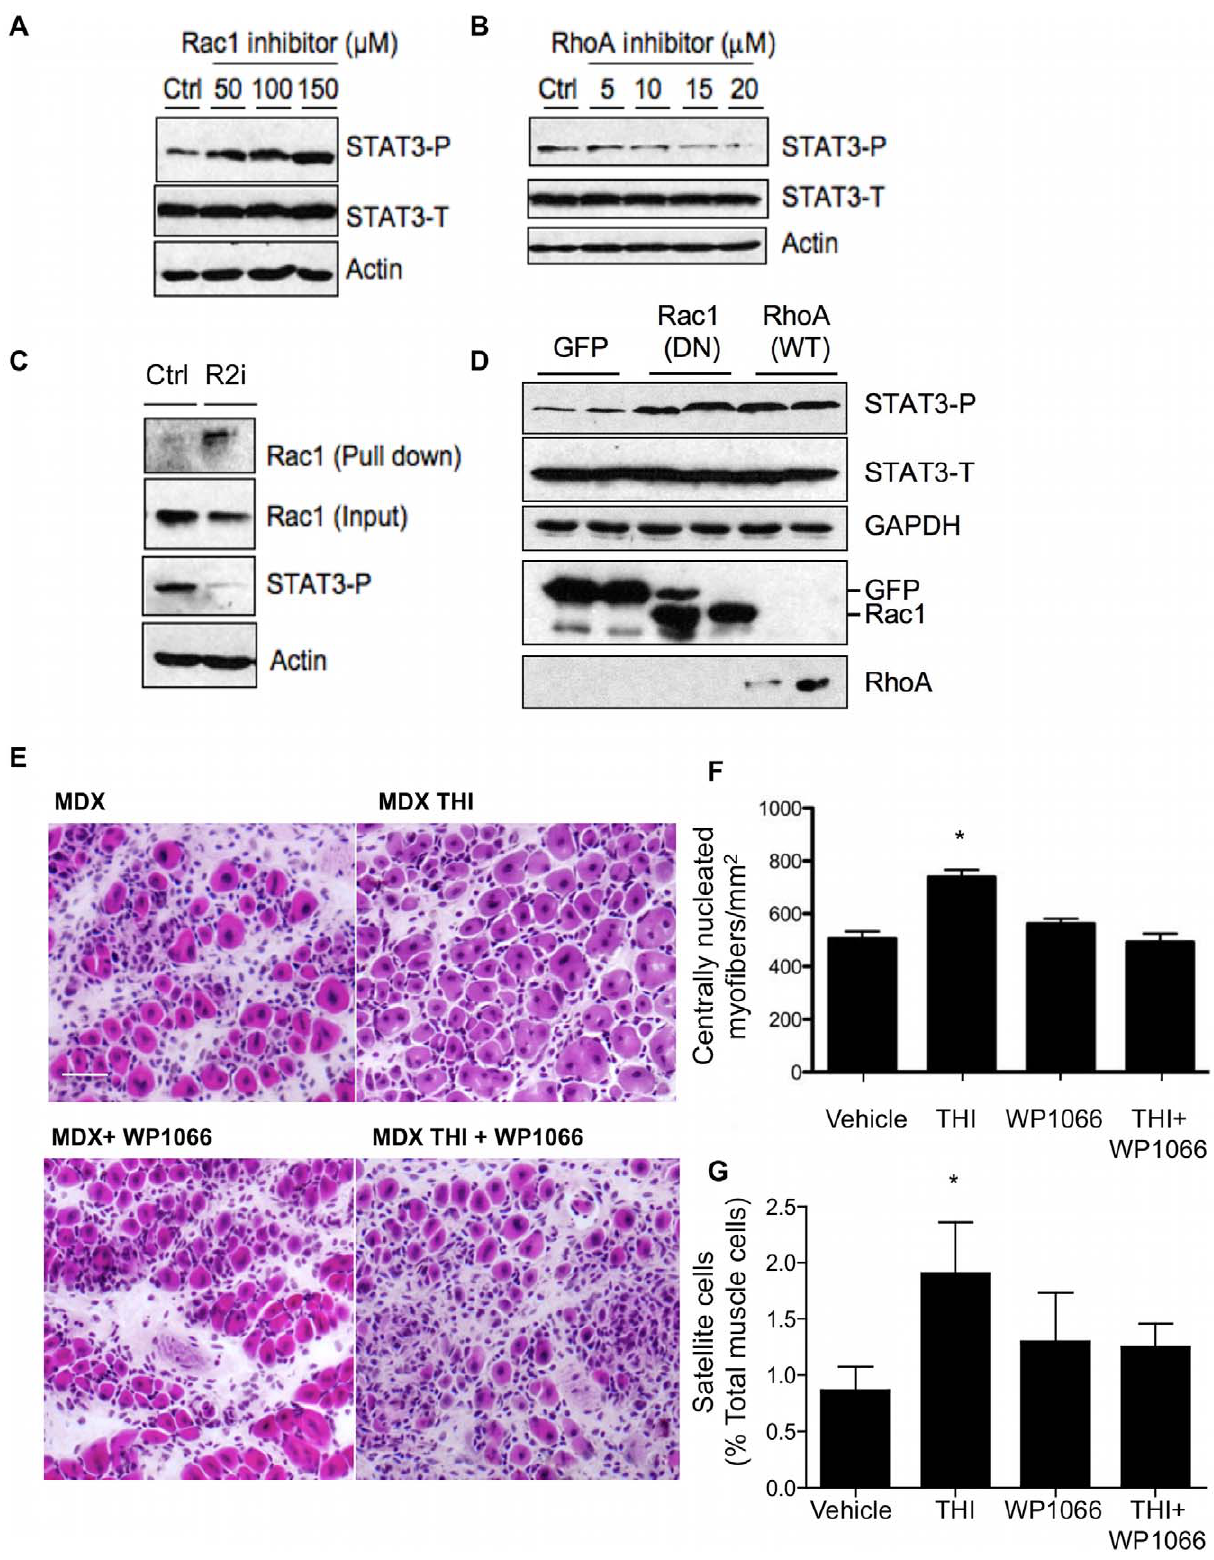
Figure 7. S1P activation of STAT3 is mediated via an S1PR2/RhoGTPase pathway. SC-derived myoblasts were treated with indicated dose of: A) Rac1 inhibitor, or B) RhoA inhibitor for 24 hours in complete media, and cell lysates were immunoblotted with indicated antibodies. Levels of total STAT3 (STAT3-T) and phosphorylated STAT3 (STAT3-P) were measured and compared to actin loading control. C) SC-derived myoblasts were treated with 10 m M S1PR2 antagonist JTE-013 (R2i) for 20 hours, cells were incubated in fresh media for 5 minutes with or without R2i, and activated